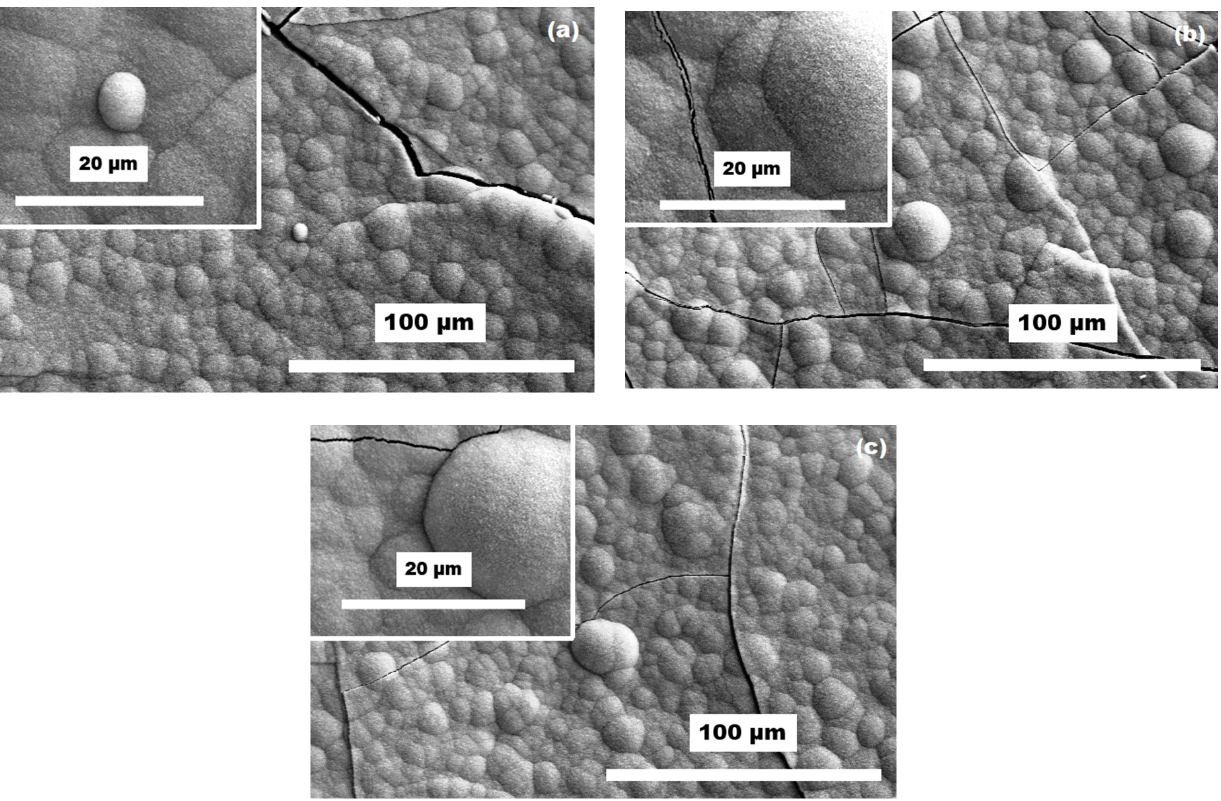
Figure 3. Surface of coatings after in vitro test: ( a ) THA, ( b ) TANHA, ( c ) TAPHA.